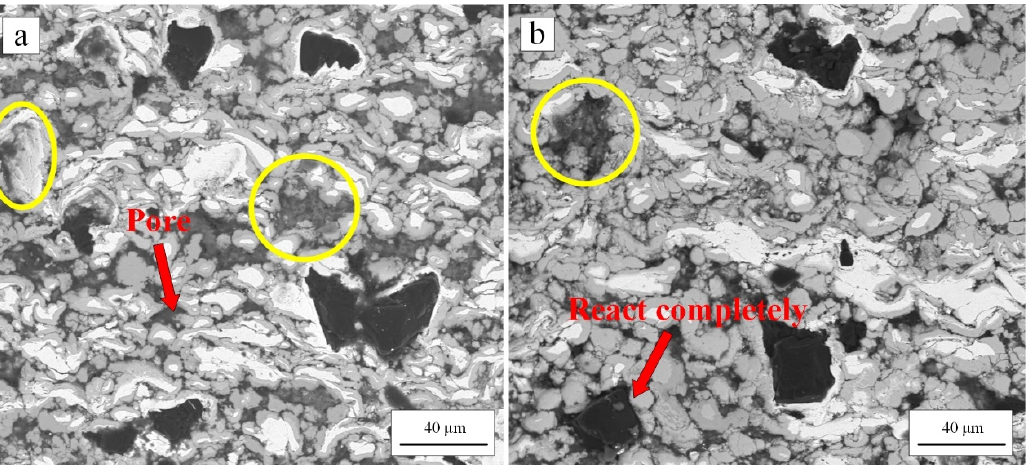
Figure 7. Backscattered SEM images of the cross-section of diamond/Ni/Al coating after 400 °C ( a ) and 500 °C ( b ) heat-treatment.